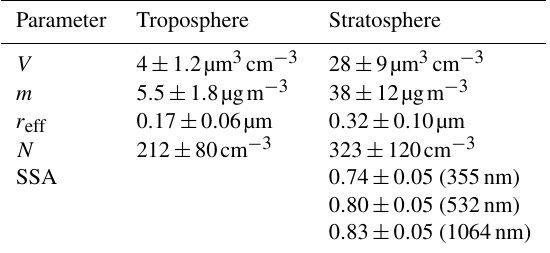
Table 2. Lidar inversion products (assuming spherical particles) for the tropospheric layer (5–6.5km) and stratospheric smoke layer (15–16km). Layer-mean values (and retrieval uncertainties) of the particle volume concentration V , mass concentration m , effective radius r eff , number concentration N , and single scattering albedo SSA are given. The lidar inversion analysis considers 10%–15% uncertainty in the measured optical properties.